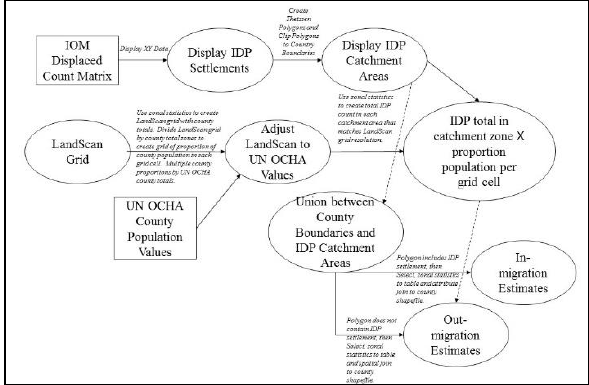
Figure 7. Flow Chart Diagram of Steps to Produce Migration